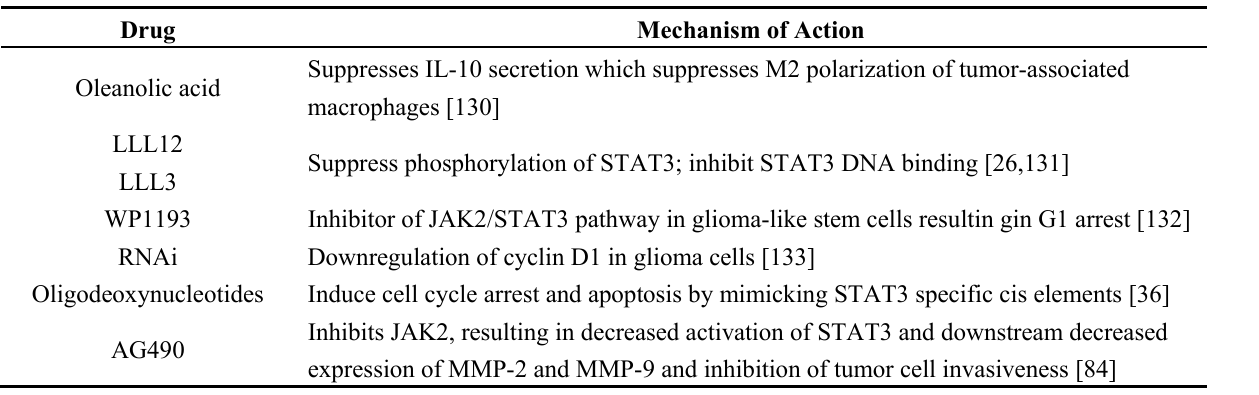
Table 2. Anti-tumor therapies targeting